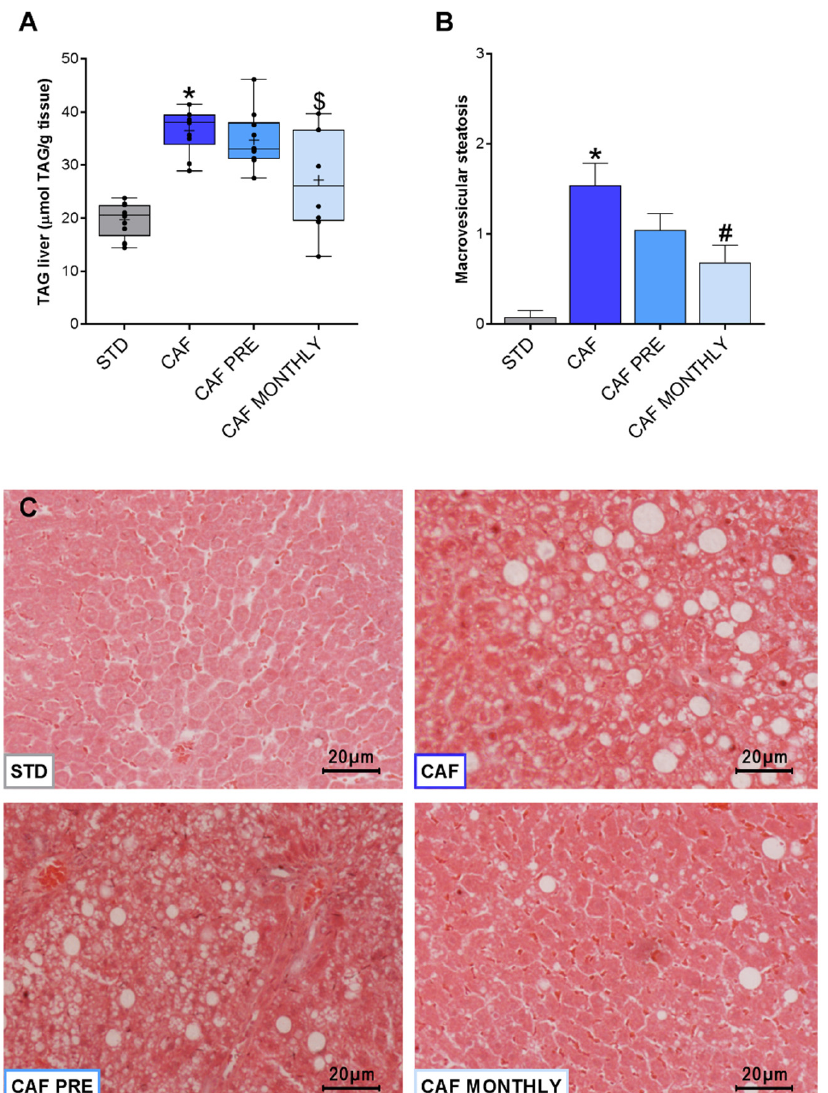
Figure 6. Effects of GSPE treatment on liver steatosis. ( A ) Simultaneous treatment with GSPE reduces liver lipid accumulation; ( B ) Macrovesicular steatosis reduction after simultaneous supplementation with GSPE; ( C ) Hematoxilin-eosin staining of representative histological sections of liver from STD, CAF, CAF PRE, and CAF MONTHLY rats. Scale bar = 10 µ m in all pictures. STD: lean rats fed a standard diet; CAF: rats fed a cafeteria diet; CAF PRE: rats receiving preventive treatment of GSPE during 10 days before cafeteria diet intervention; CAF MONTHLY: rats receiving GSPE treatment during 5 days once per month simultaneously fed with cafeteria diet. Levels of triglycerides are represented as boxplots showing the median and the IQR. Means are represented as +. Macrovesicular steatosis score values are represented as means ± SEM. * p -value < 0.05 compared to STD rats. # p -value < 0.05 compared to CAF rats. Trends: $ 0.05 < p -value < 0.1 compared to CAF